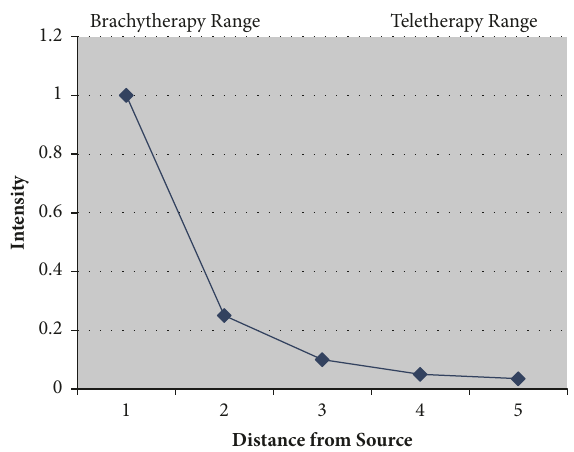
Figure 4: Radiotherapy modalities include external beam radio- therapy (EBRT) or brachytherapy (BT). These two classes of modal- ities are related by the inverse square law. Inverse square law states that as one moves away from the radioactive source, the amount of radiotherapy that can be measured is inversely proportional to the square of the distance.